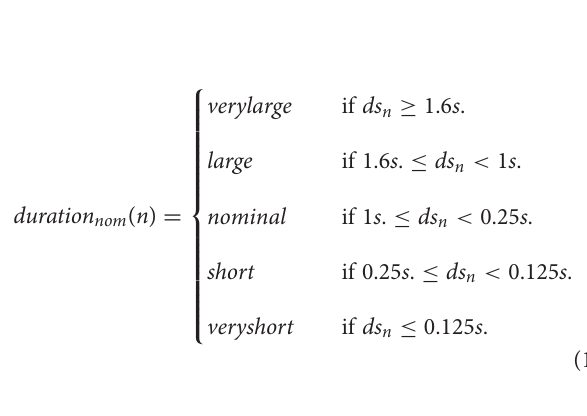
FIGURE 2 | Basic Narmour structures P, D, R, and ID, and their derivatives VR, IR, VP, and IP.